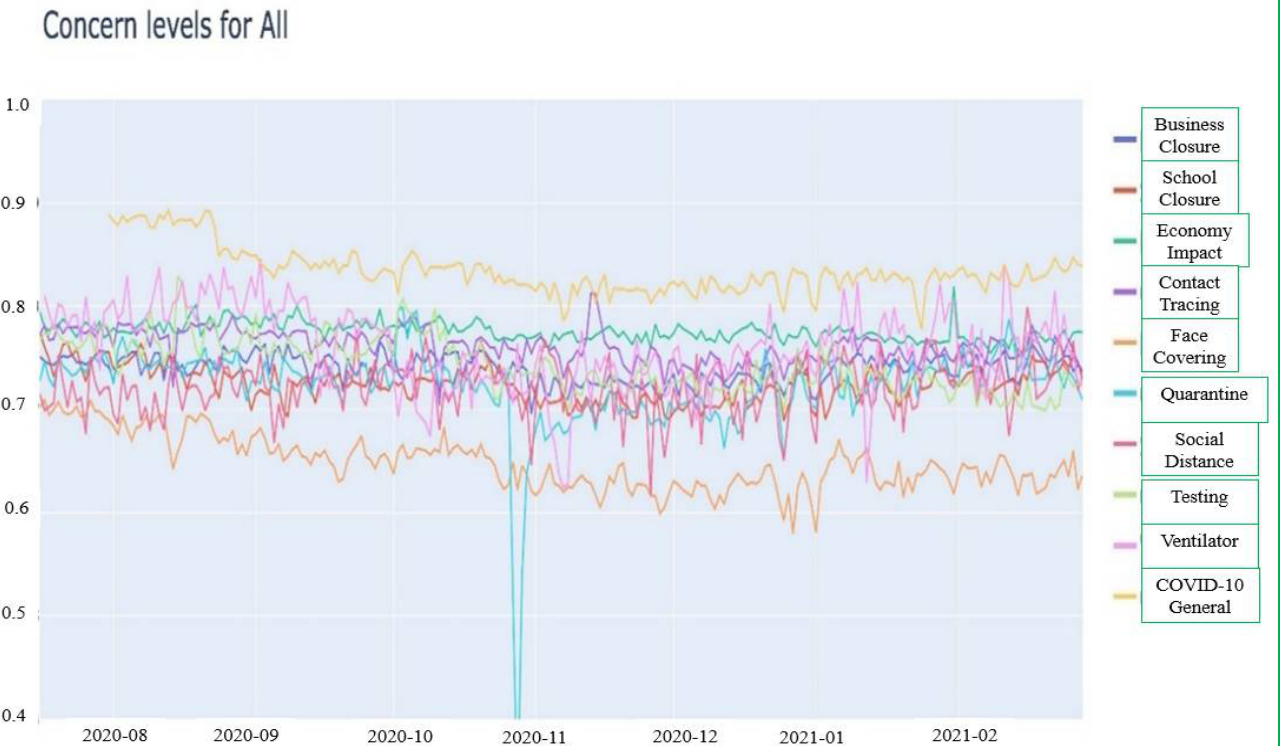
Figure 2. Concern Level Trends of All Policies.